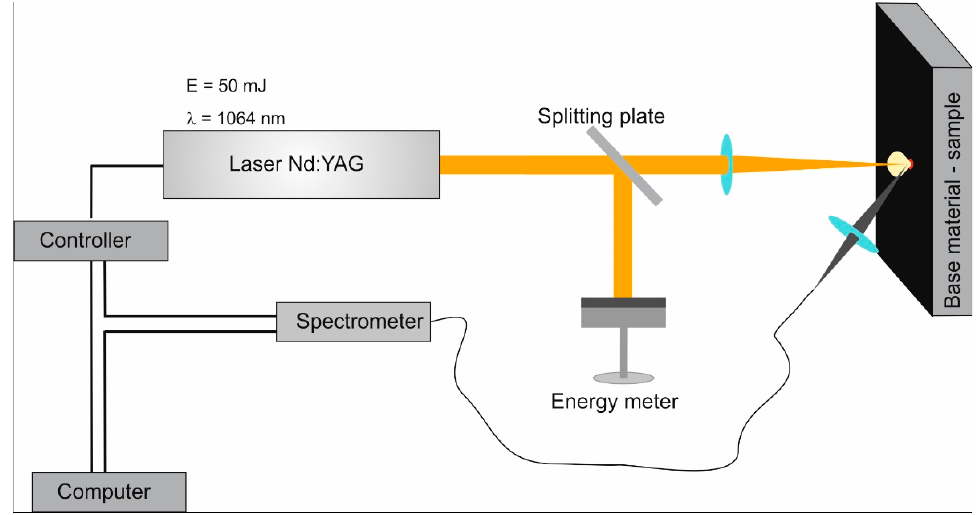
Figure 1. Scheme of the measurement system.